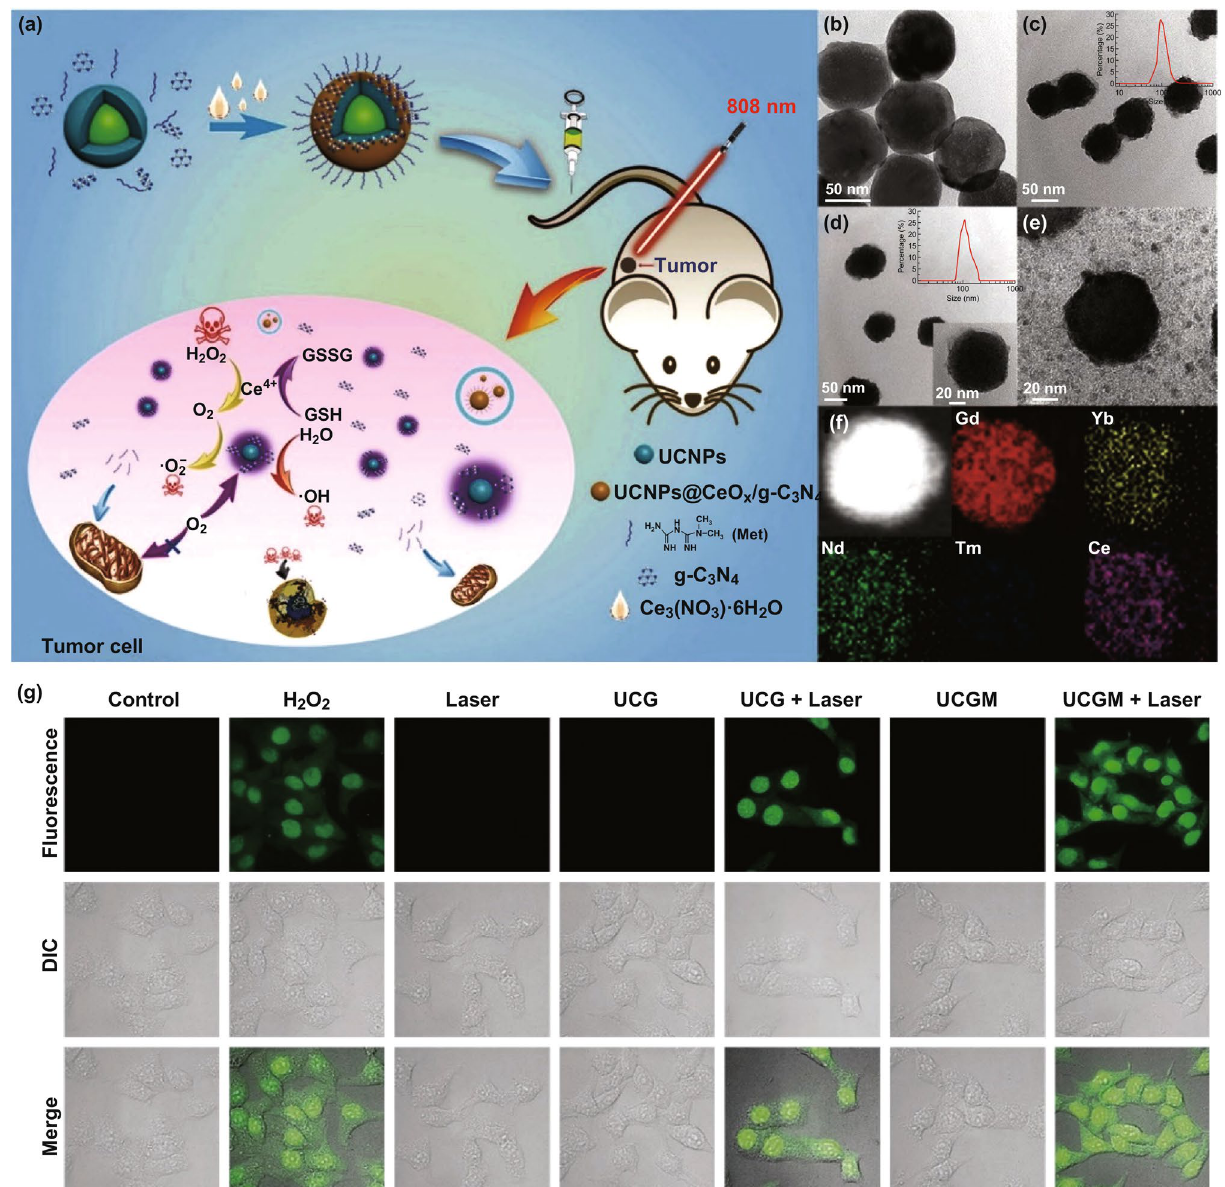
Fig. 8 a Schematic diagram of the synthesis and action mechanism of UCNPs@CeOx/g-C 3 N 4 . b TEM image of NaGdF4:Yb, Tm@ NaGdF 4 :Yb, Nd NPs. c TEM image of UCG NPs and the DLS curve of UCG NPs. d TEM images of UCGM NPs. e TEM images of UCGM NPs treated with